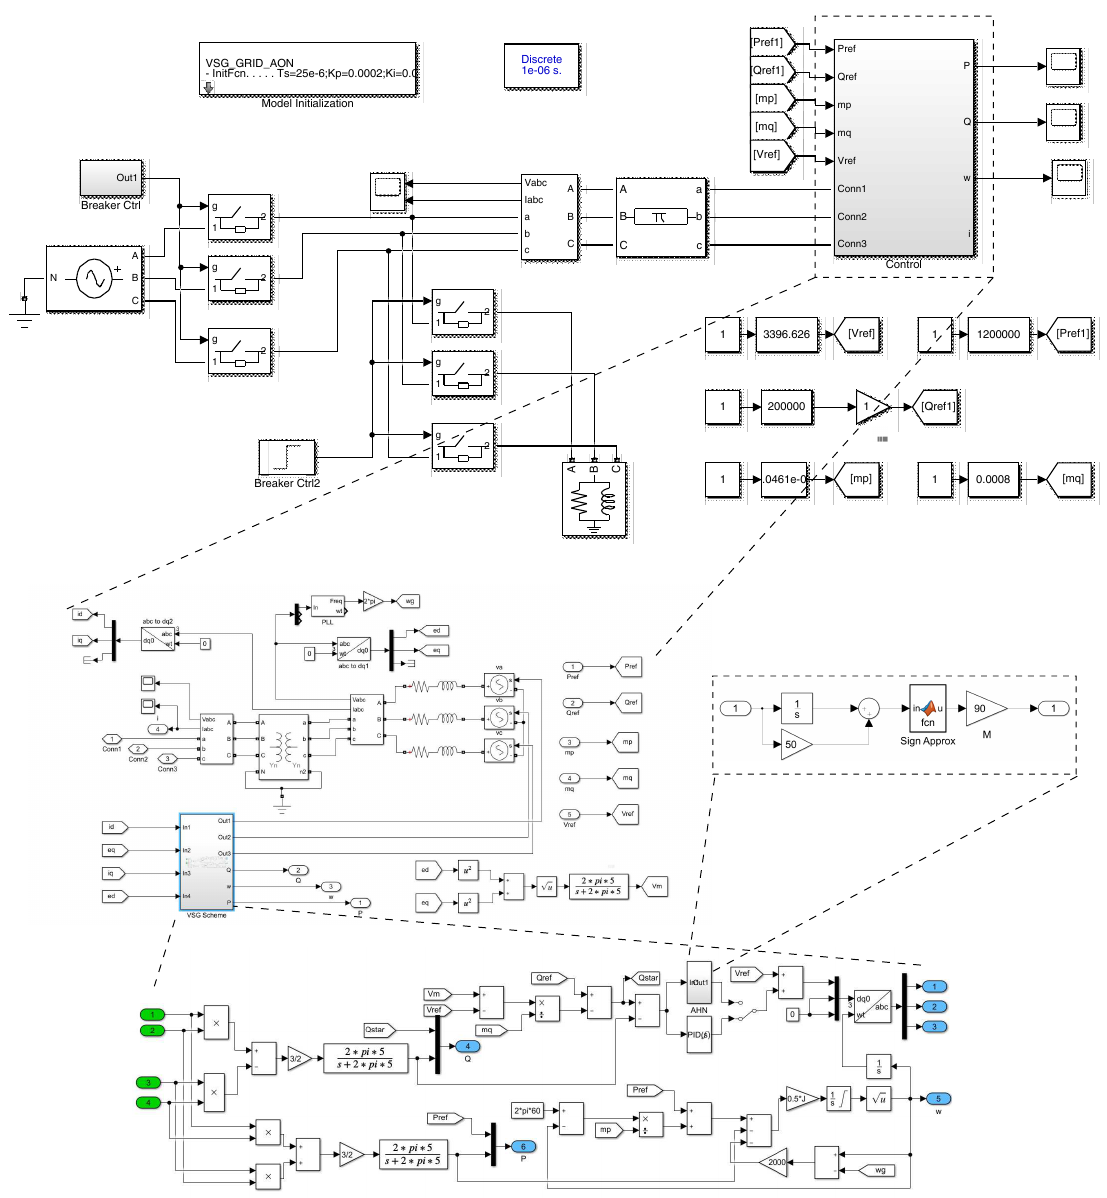
Figure 8. Block diagram implemented in